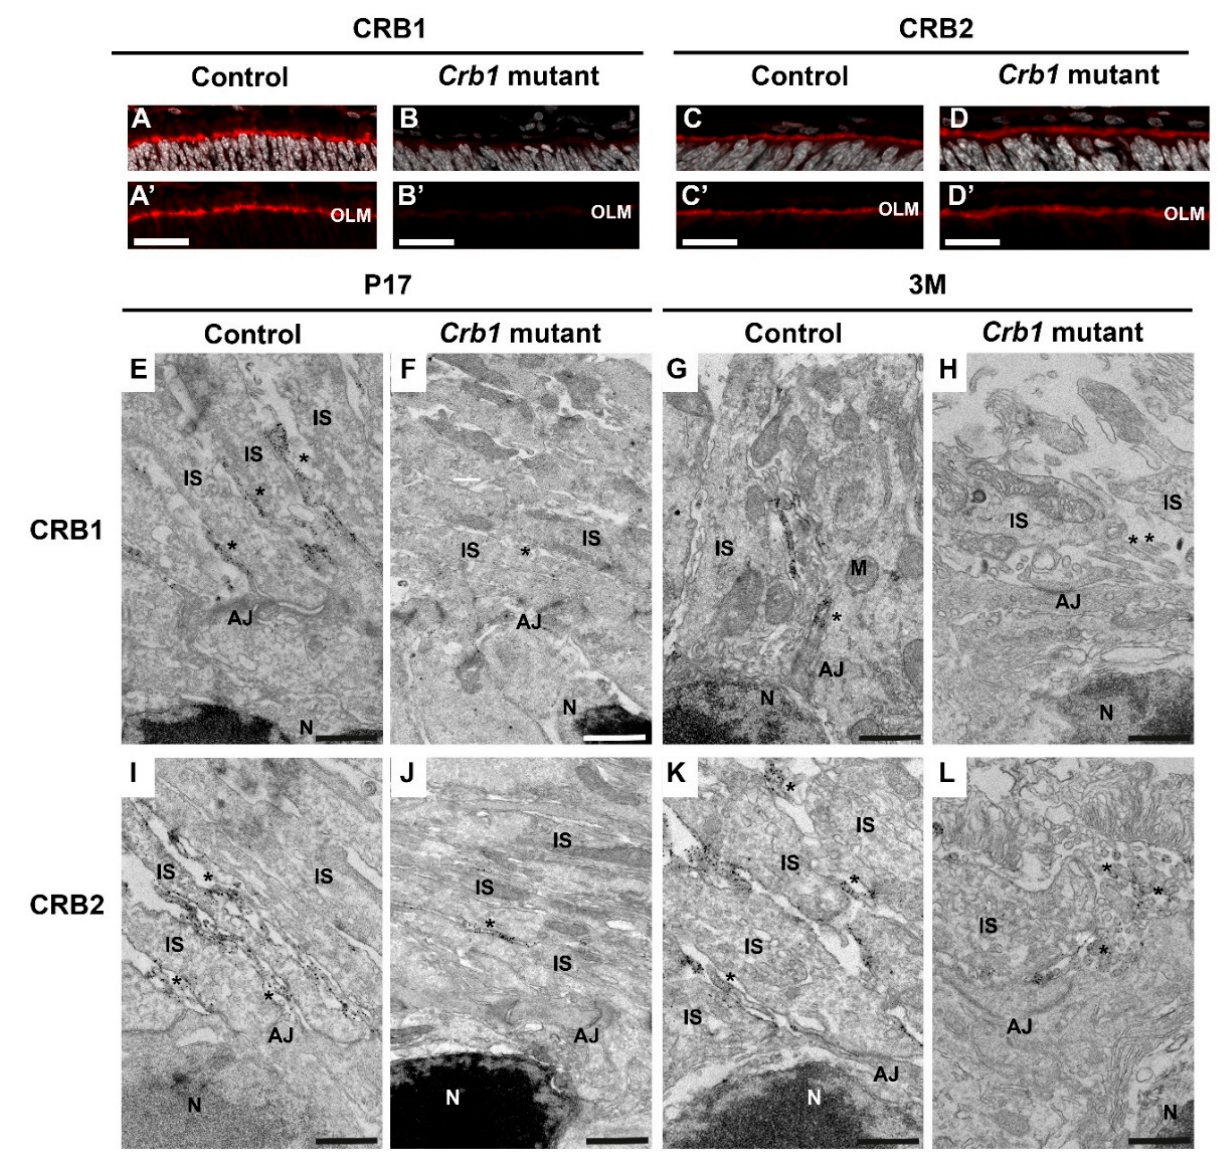
Figure 4. CRB1 is present at the subapical region (SAR) of MGCs in control rats while CRB2 is present at the SAR of both photoreceptors and MGC in control and Crb1 mutant rats. ( A – D ) Immunohistochemical analysis of CRB1 ( A , B ) and CRB2 ( C , D ) in P5 control and Crb1 mutant rats at the OLM. ( E – L ) Subcellular localization of CRB1 and CRB2 in control and Crb1 mutant rats using immuno-electron microscopy. CRB1 is present at the SAR of MGC in both P17 ( E ) and 3M control retina ( G ), while the mutant CRB1 INDEL variant protein in Crb1 mutant rats is sporadically detectable in P17 ( F ) and 3M ( H ). F and H show representative images lacking detectable label. CRB2 is present at the SAR of MGCs as well as photoreceptors in both control and Crb1 mutant rat retinas at both ages ( I – L ). n = 2 animals used per time point. AJ = adherens junctions; IS = inner segments; INL = inner nuclear layer; M = mitochondria; N = nucleus; OLM = outer limiting membrane; ONL = outer nuclear layer; * = Müller glial villi. Scale bars ( A – D ) = 20 µm; ( E – L ) = 1 µm.